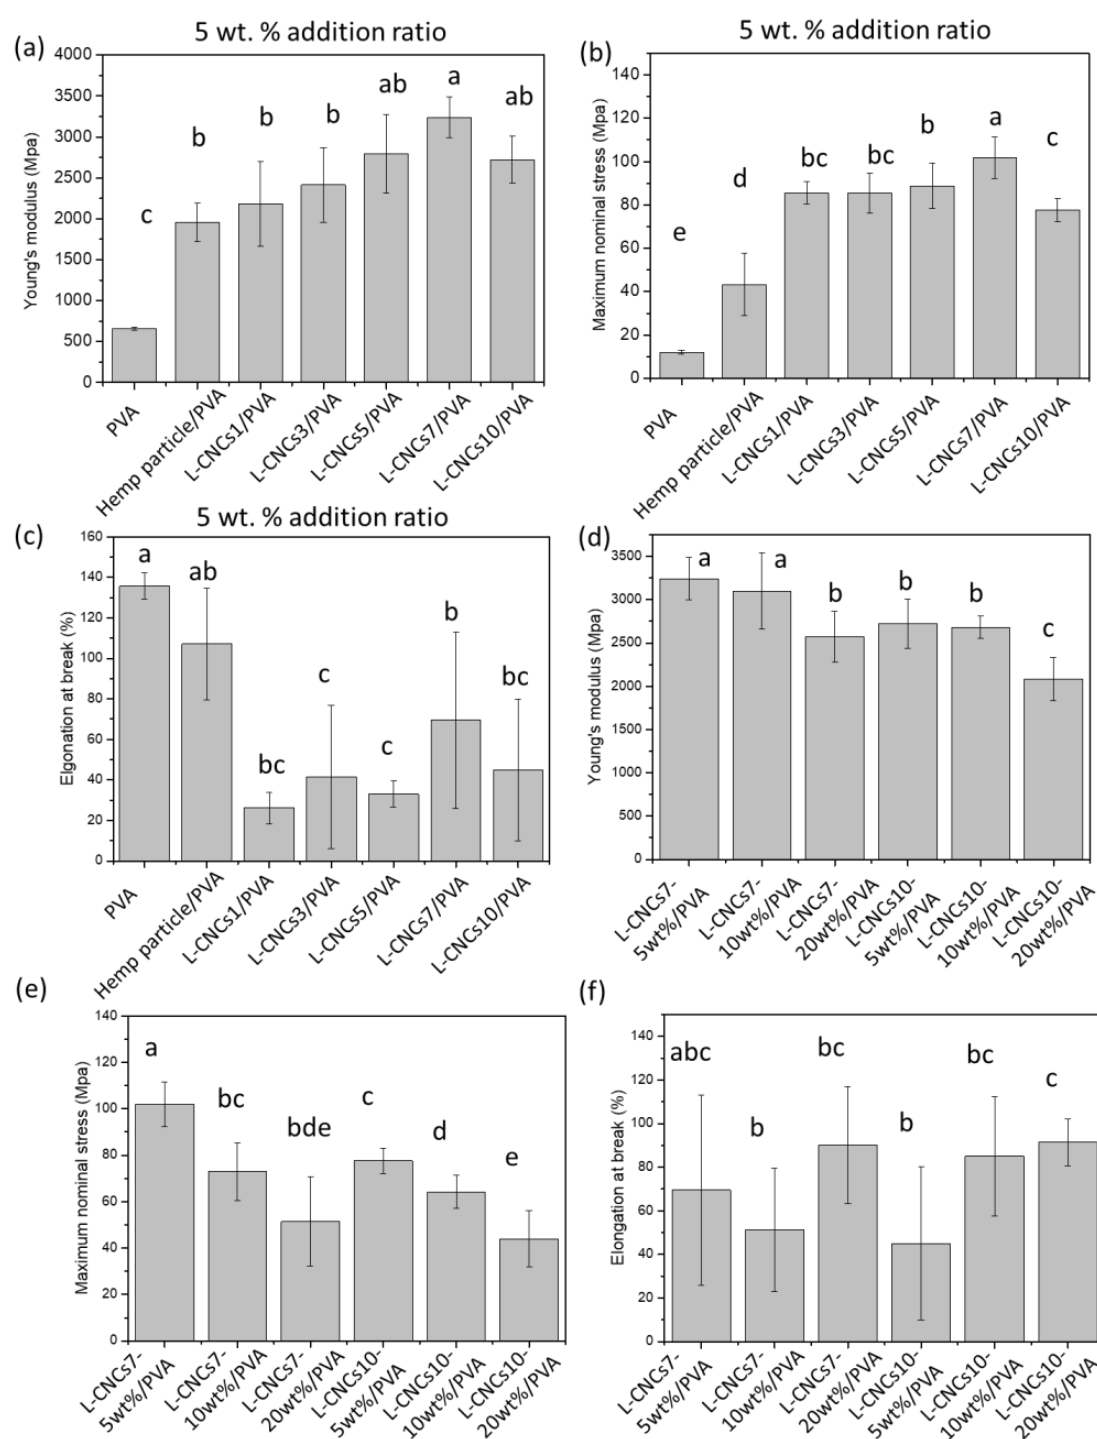
Figure 10. ( a ) Young’s modulus, ( b ) stress, and ( c ) elongation of pure PVA, hemp particle/PVA film and L-CNCs/PVA films at addition ration of 5 wt. %. ( d ) Young’s modulus, ( e ) stress, and ( f ) elongation of L-CNCs7 and L-CNCs10 at different addition ratio (5 wt. %, 10 wt. %, and 20 wt. %). Error bars indicate the standard deviations of the samples. Different superscript letters (a, b, c, d, e) represent statistically significant differences among groups ( p ≤ 0.05); the superscript letters ab means no significant difference among ab and a or ab and b; the superscript letters bc means no significant difference among bc and b or bc and c; abc means no significant difference among abc and a, abc and b or abc and c; bde means no significant difference among bde and b, bde and d or bde and e.